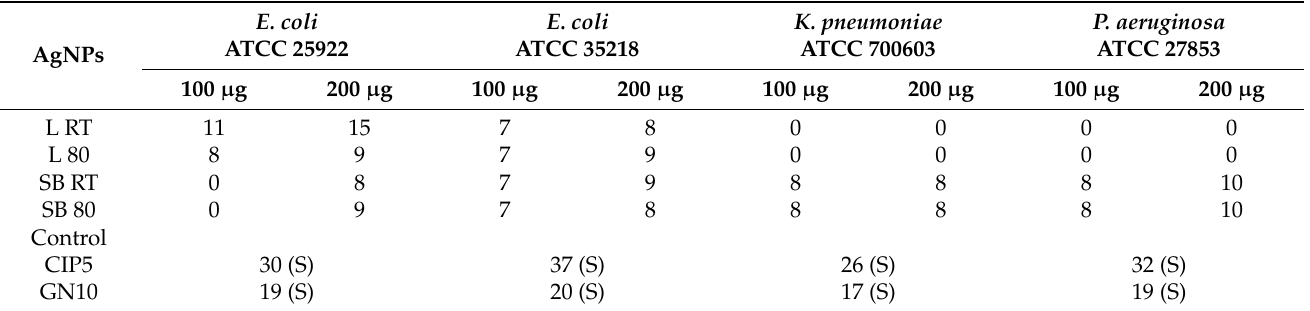
Table 2. Zone of inhibition (mm) of D. villosa leaves and stem AgNPs against Gram-negative bacteria strains .